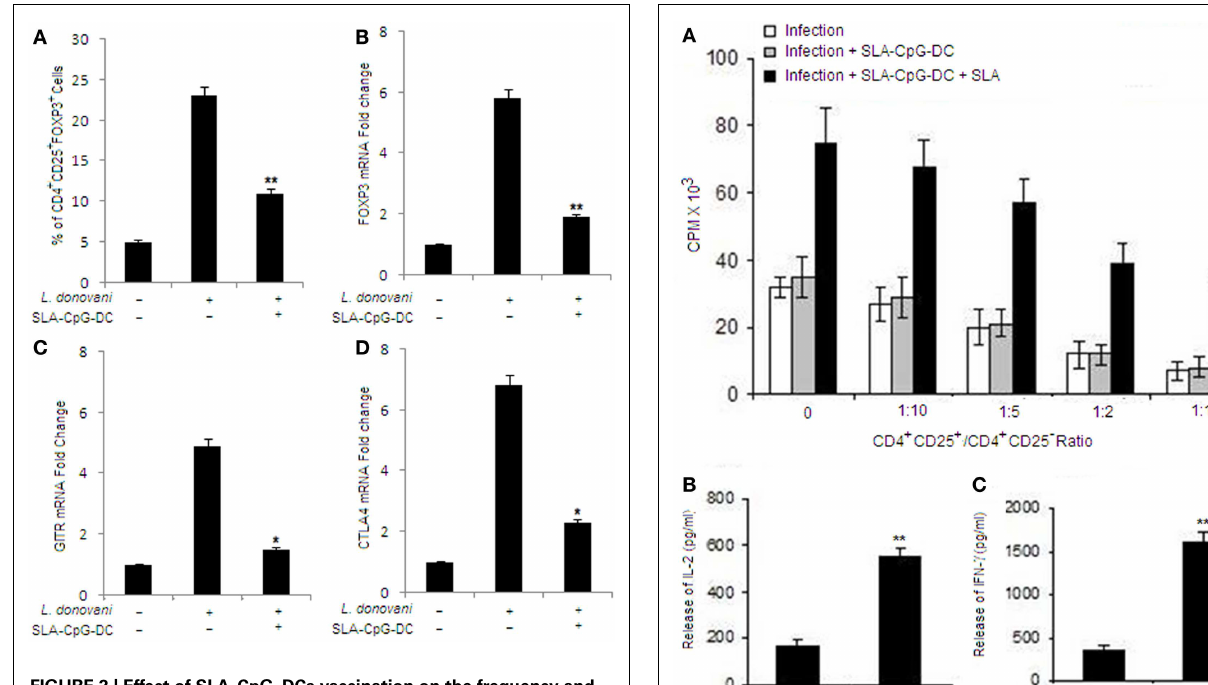
T cells from control mice showed lower levels of IL-10 and TGF- β